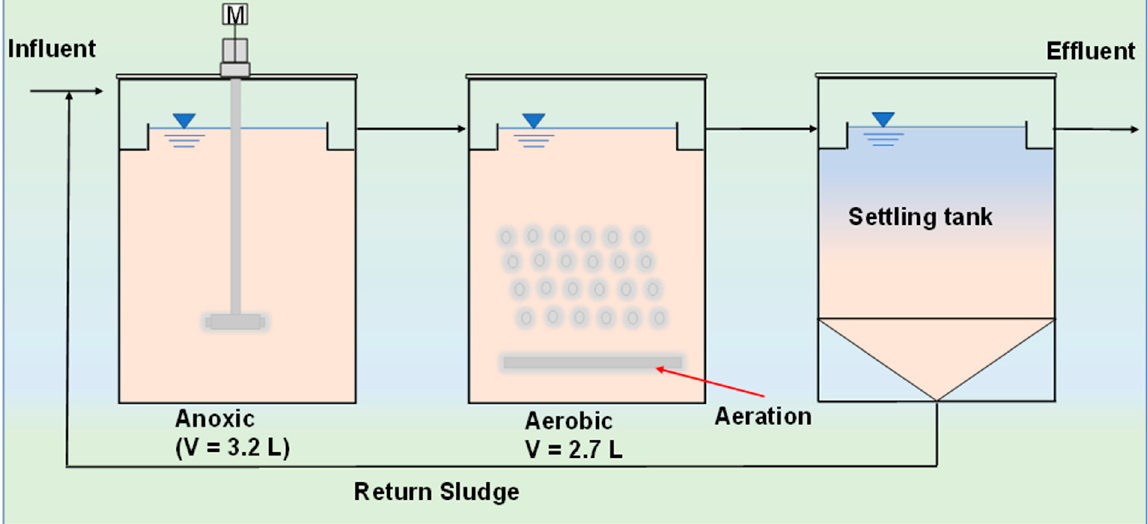
Figure 6. Schematic of lab scale reactor setup with a schematic for biodegradation of